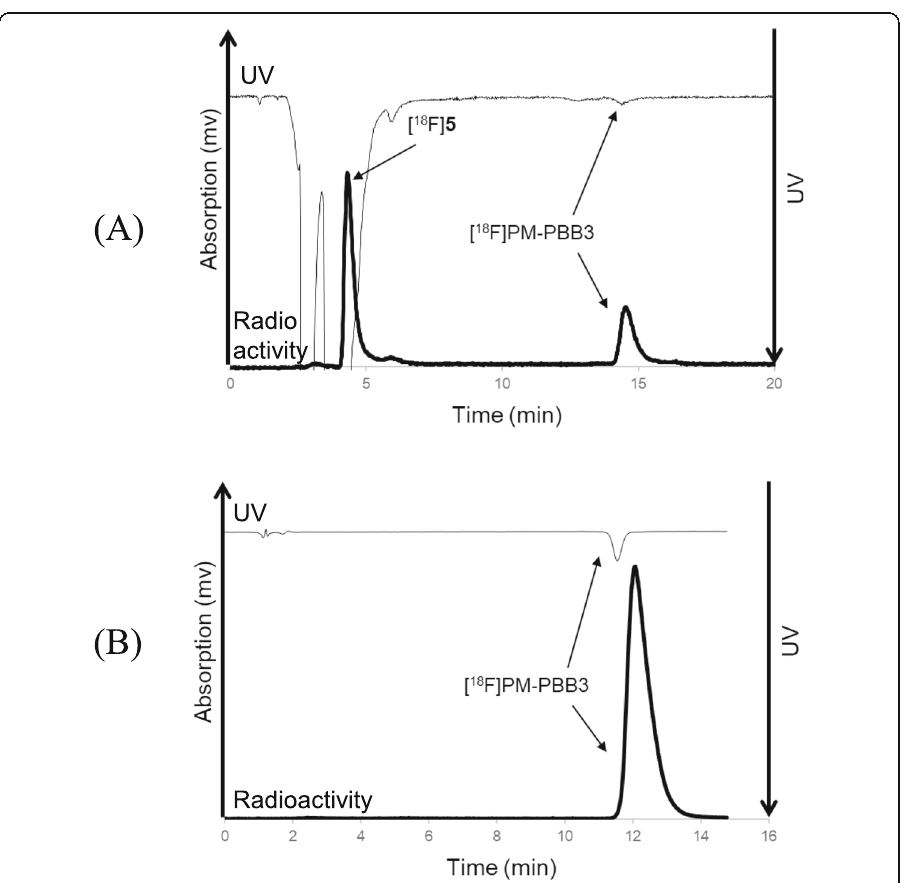
Fig. 6 Preparative HPLC ( A ) and analytical HPLC ( B ) chromatograms of [ 18 F]PM-PBB3 by 18